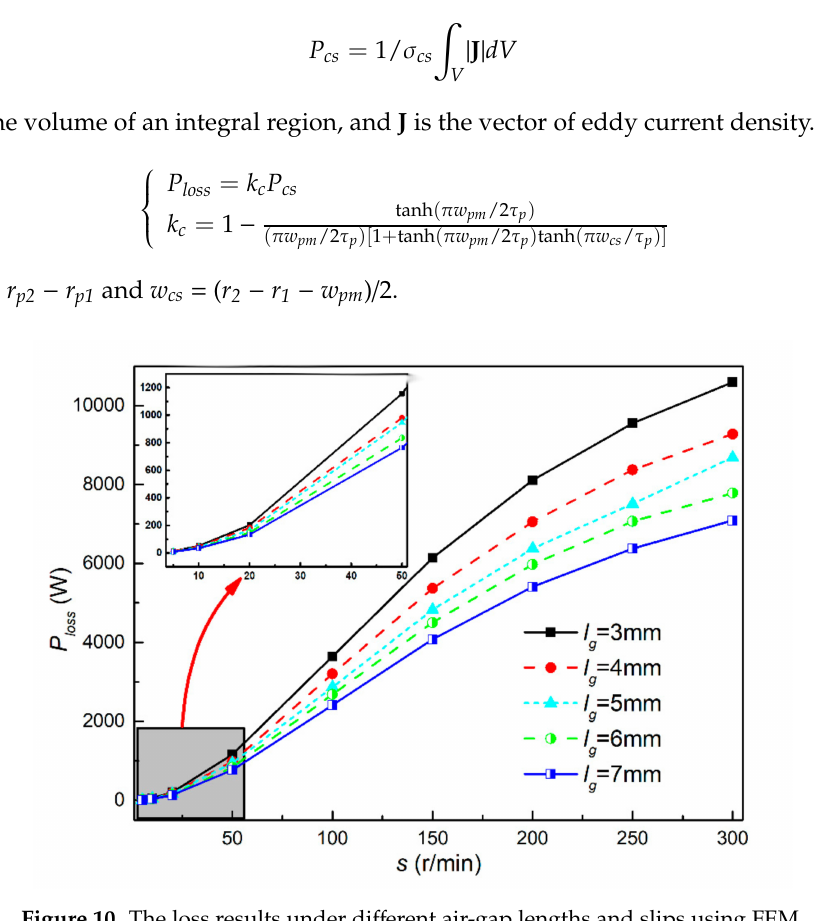
Figure 10. The loss results under di ff erent air-gap lengths and slips using FEM.